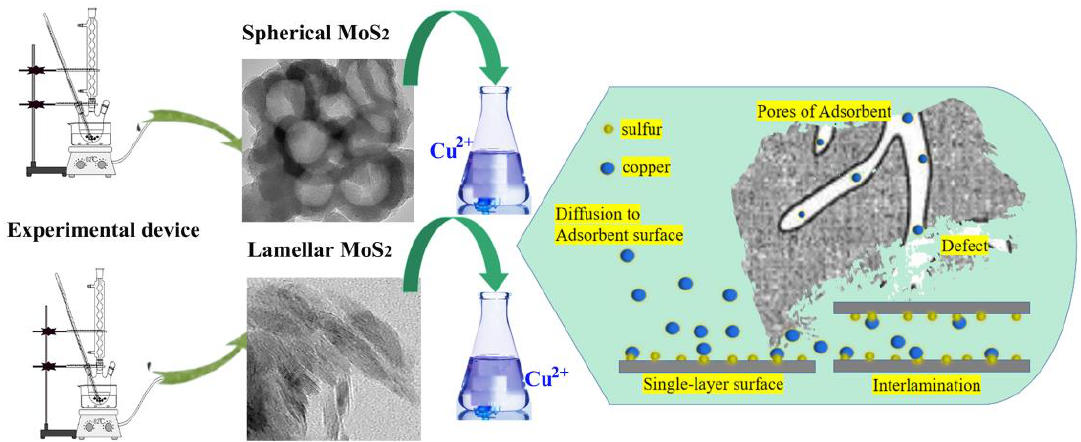
Figure 1. Schematic of experimental and adsorption processes.